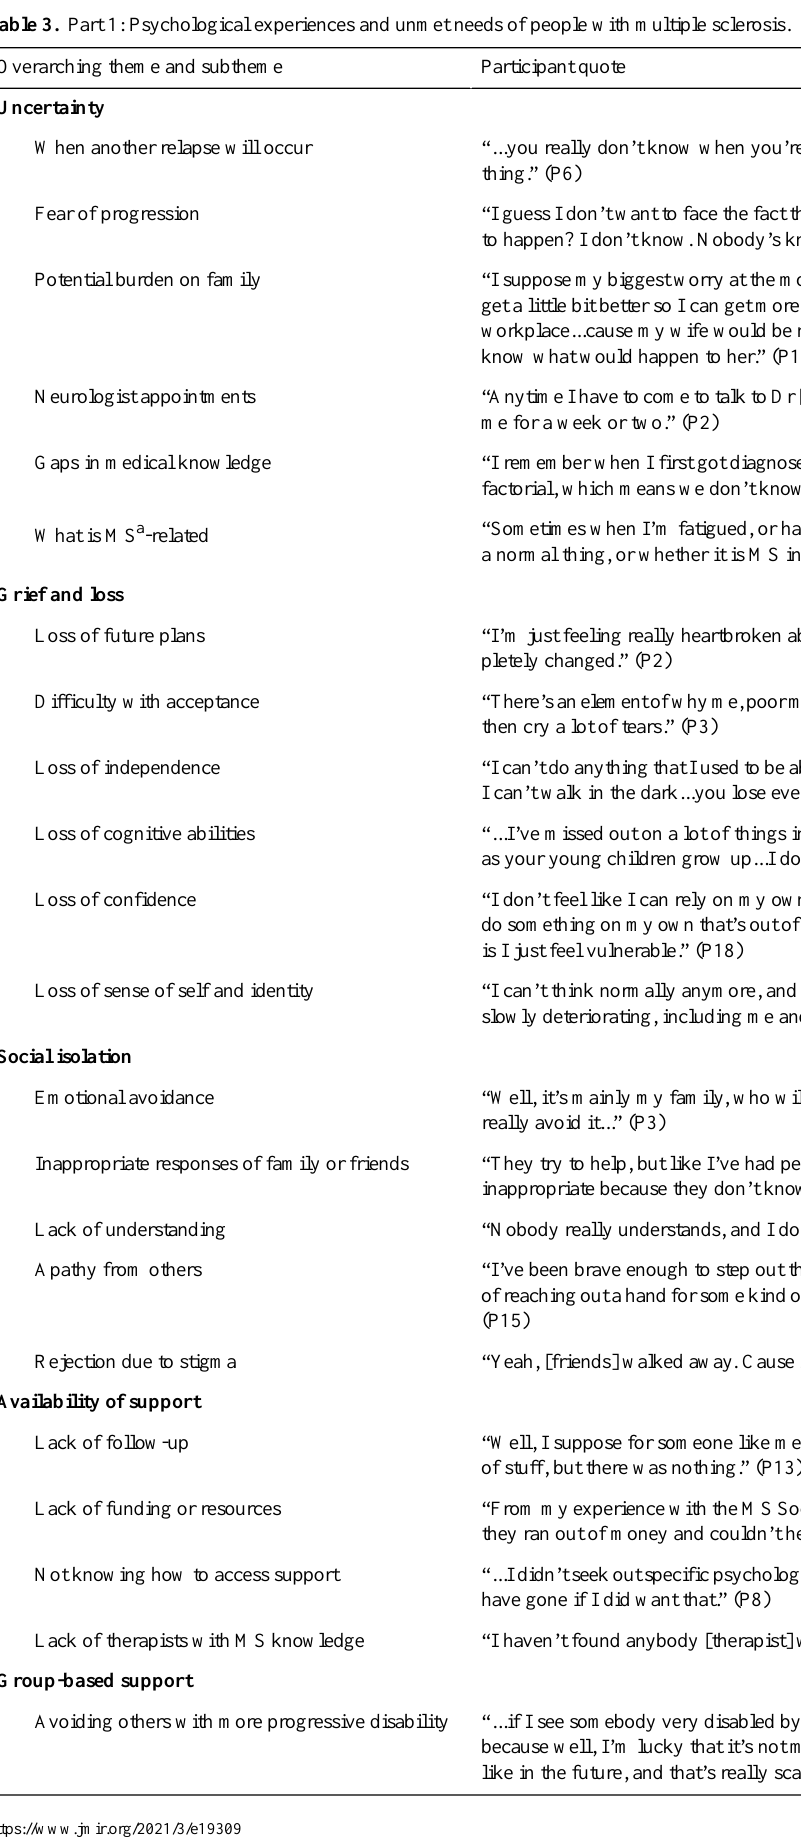
Table 3. Part 1: Psychological experiences and unmet needs of people with multiple sclerosis.